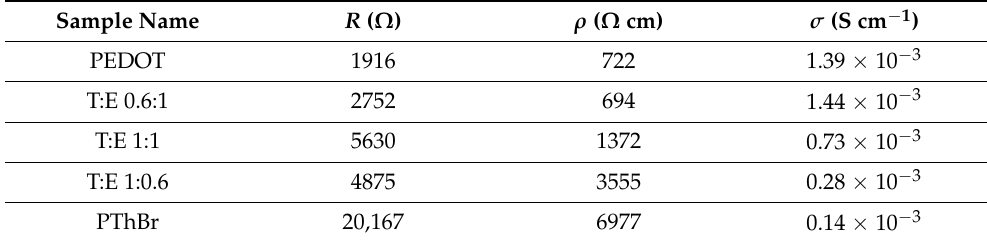
Table 4. Electrochemical properties of prepared